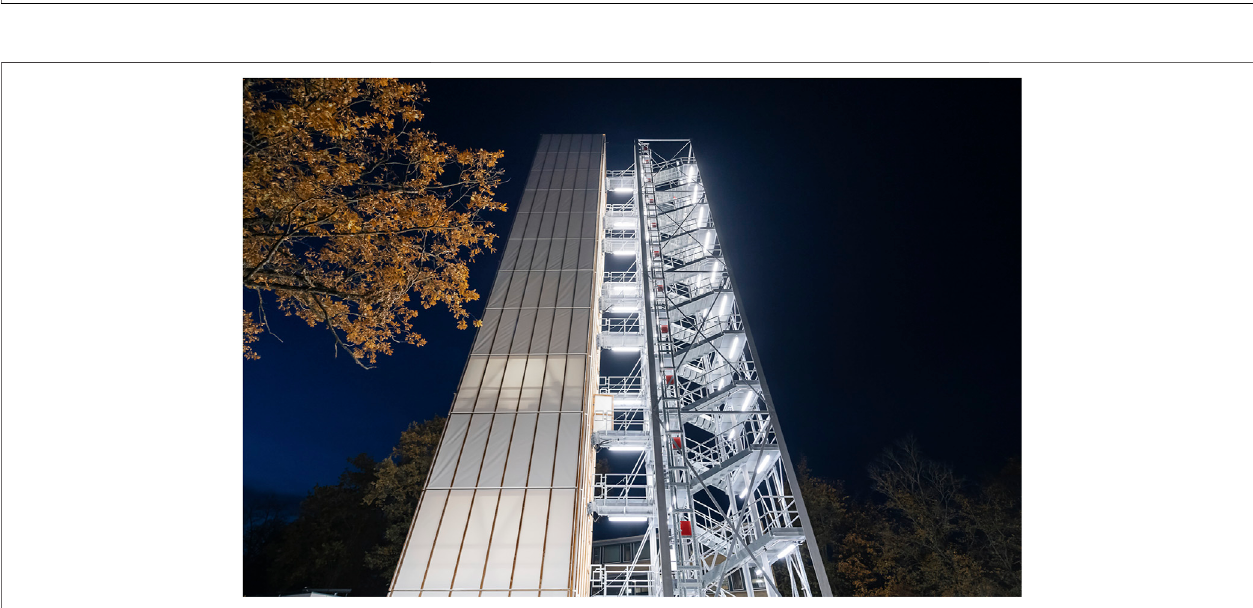
FIGURE 13 | View of the completed high-rise building D1244 (Source: René Müller).